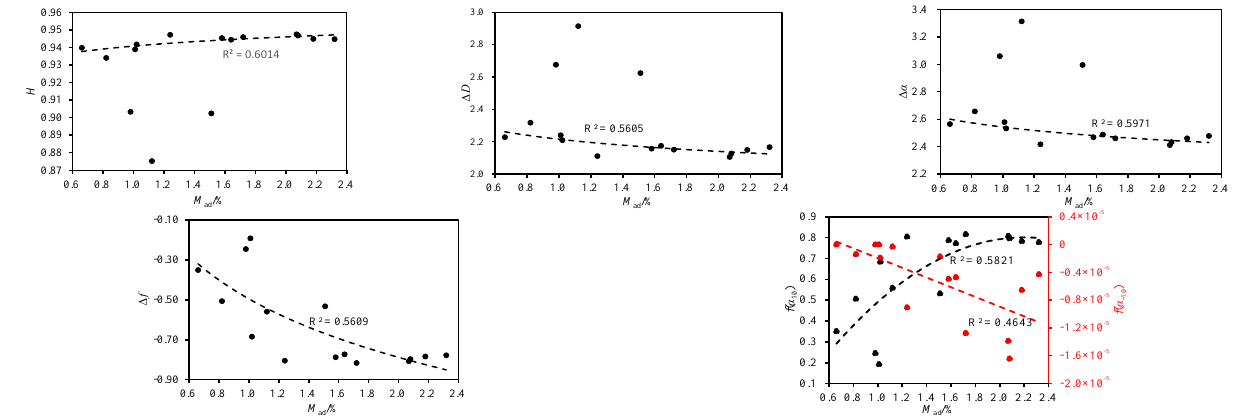
fore, M ad is positively correlated with H and negatively correlated with ∆ D , ∆ α and ∆ f (Figure 10). With the deepening of dryness ( M ad decreasing), the H value of the middle- high rank coal reservoir shows a downward trend [38]. The ∆ D , ∆ α and ∆ f values of medium-high rank coal show an increasing trend, which means that the increase in internal moisture in coal enhances the heterogeneity of the pore structure of medium-high rank coal while reducing its connectivity, which may be closely related to the capillary phenomenon in the pore. Under the action of capillary force, the water molecules in the medium-high rank coal adsorb on the pore surface or fill in the small size pores and throats, and the reser- voir changes from the macropore-micropore coexisting type to the micropore dominant type, with narrow pore throats and homogenization of pores [39].